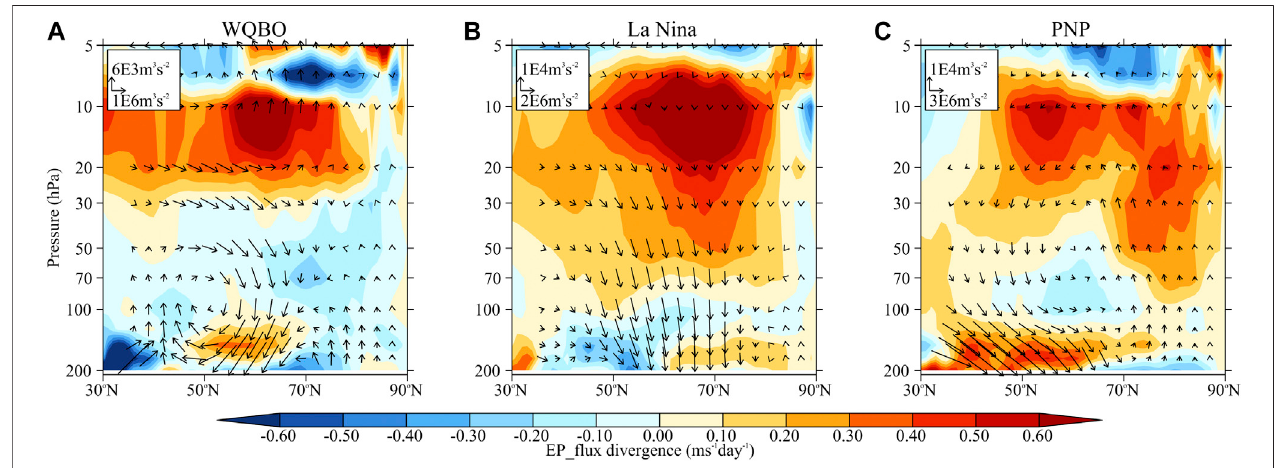
FIGURE 9 | Composite anomalies of EP fl ux (vectors) and EP fl ux divergence (color shading) for (A) WQBO phases, (B) La Niña and (C) positive SST anomalies in the North Paci fi c (PNP) during boreal winter, based on ERA-Interim data for 1979 to 2016. The events selected for composite analysis are listed in Table 2 .